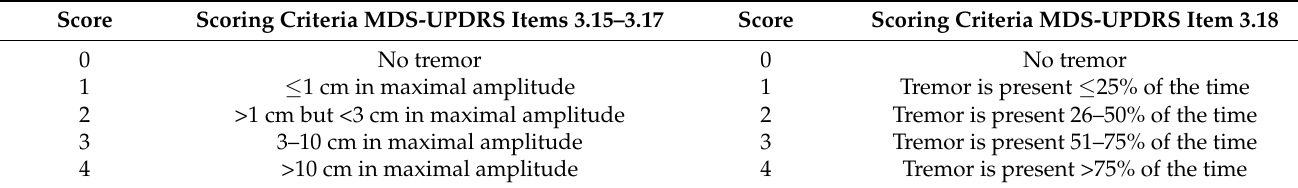
Table 1. Description of MDS-UPDRS scoring criteria [12]. Scoring Criteria MDS-UPDRS Items 3.15–3.17 Score Scoring Criteria MDS-UPDRS Item